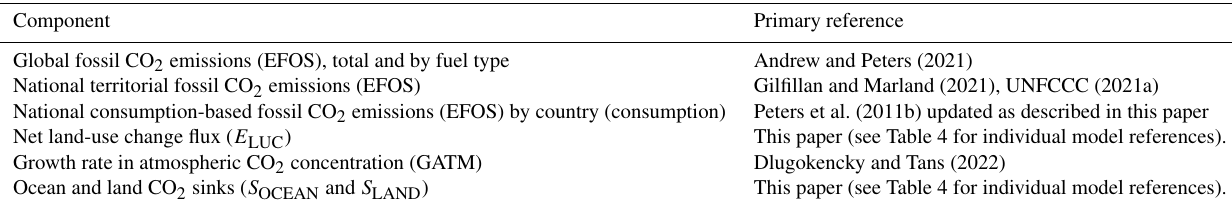
Table 2. How to cite the individual components of the global carbon budget presented here. Component Primary reference Global fossil CO 2 emissions (EFOS), total and by fuel type Andrew and Peters (2021) National territorial fossil CO 2 emissions (EFOS) Gilfillan and Marland (2021), UNFCCC (2021a) National consumption-based fossil CO 2 emissions (EFOS) by country (consumption) Peters et al. (2011b) updated as described in this paper Net land-use change flux ( E LUC ) This paper (see Table 4 for individual model references). Growth rate in atmospheric CO 2 concentration (GATM) Dlugokencky and Tans (2022) Ocean and land CO 2 sinks ( S OCEAN and S LAND ) This paper (see Table 4 for individual model